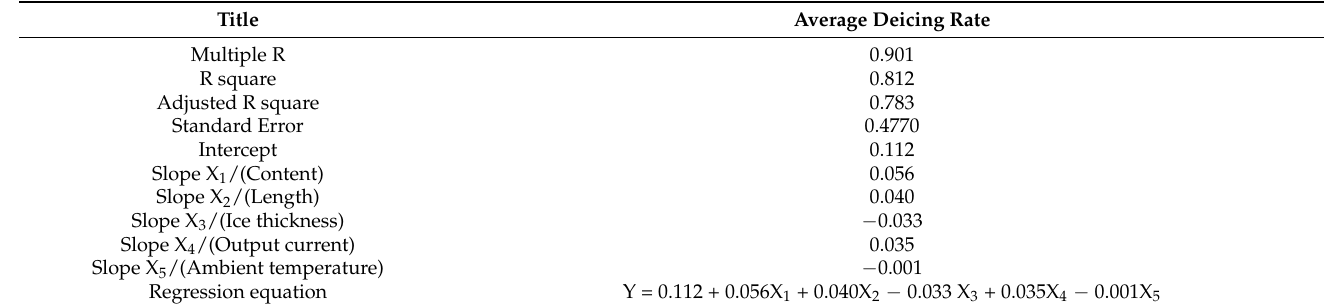
Table 4. The relationships between average deicing rate and factors.